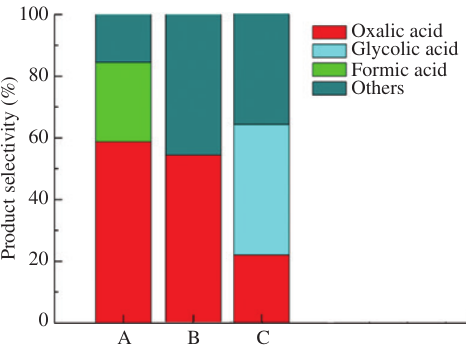
Figure 5: Distribution of products of the degradation of the three model compounds of lignin over CuFeS (B) 1-phenyl-2- phenoxyethanol, (C) 2-(2-methoxyphenoxy)-1-(4- methoxyphenyl)ethan-1-ol.